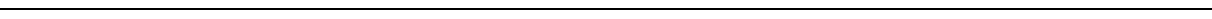
Fig. 3 Chromatin-state transitions re fl ect mDA development. a RNA-seq: Volcano plot showing differential gene expression between NPC and mDA neurons. Differentially expressed genes with an adjusted p -value < 0.05 obtained by Wald test are shown. b Volcano plot as in a where differentially expressed and H3K27me3 and/or H3K9me3-marked genes are colored according to: marked in mDA – pink, marked in NPC – green, and marked in both mDA and NPC – gray. c ChIP-seq heatmaps showing the abundance of H3K27me3, H3K4me3, and H3K9me3 as RPKMs ± 10 kb around TSS of genes that were upregulated in mDA and associated with a chromatin state containing H3K27me3 and/or H3K9me3 and d genes that were downregulated in mDA and associated with a chromatin state containing H3K27me3 and/or H3K9me3, respectively. The arrow indicates H3K27me3 + genes that gain H3K9me3 in mDA. e Chromatin-state transitions between NPC and mDA neurons for upregulated genes in mDA. Colored squares indicate transitions that occurred signi fi cantly more often than expected (odds ratio, orange = more than expected, blue = less than expected, p < 0.05 according to Fisher ’ s exact test and adjusted for multiple testing). f Heatmaps of average H3K27me3, H3K4me3, and H3K9me3 RPKMs ± 10 kb around TSS of genes upregulated from NPC to mDA and K4 in NPC and K4 in mDA. g Gene ontology (GO) of the top ( − log10 (adj p -value), Fisher ’ s exact test) biological processes for upregulated genes in mDA that were K4 in NPC and K4 in mDA. h Heatmaps as in f of genes upregulated in mDA and K4/K27 in NPC and K4 in mDA. i GO of the top biological processes for upregulated genes in mDA that were K4/K27 in NPC and K4 in mDA. j Chromatin-state transitions between NPC and mDA neurons for downregulated genes in mDA ( e ). k Heatmaps as in f of genes downregulated in mDA and K4 in NPC and K4/K27 in mDA. l GO of the top biological processes for downregulated genes in mDA that were K4 in NPC and K4/K27 in mDA. m Heatmaps as in f of genes downregulated in mDA, and categorized as K4/K27 in NPC and K4/K27 in mDA. n GO of the top biological processes for downregulated genes in mDA that were K4/K27 in NPC